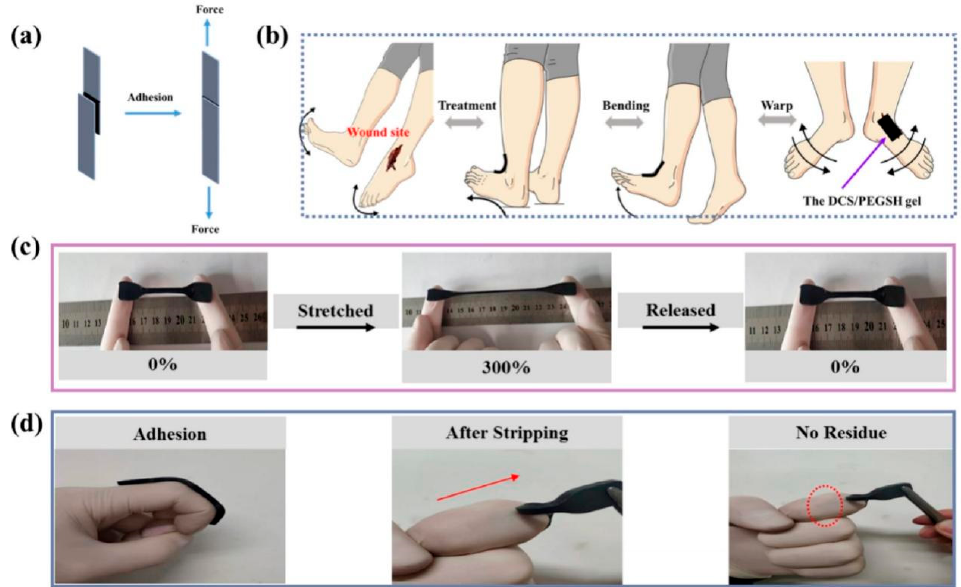
Figure 6. Adhesive performance of DCS/PEGSH composite hydrogel. ( a ) Schematic diagram of hydrogel adhesion and stretching. ( b ) Adhesion of hydrogel on different deformation joints. ( c ) At 300% recoverable strain, the hydrogel can adhere directly to the rubber glove without additional tape. ( d ) The rubber glove shows peeling hysteresis and no residue during peeling [114]. Copyright: 2021